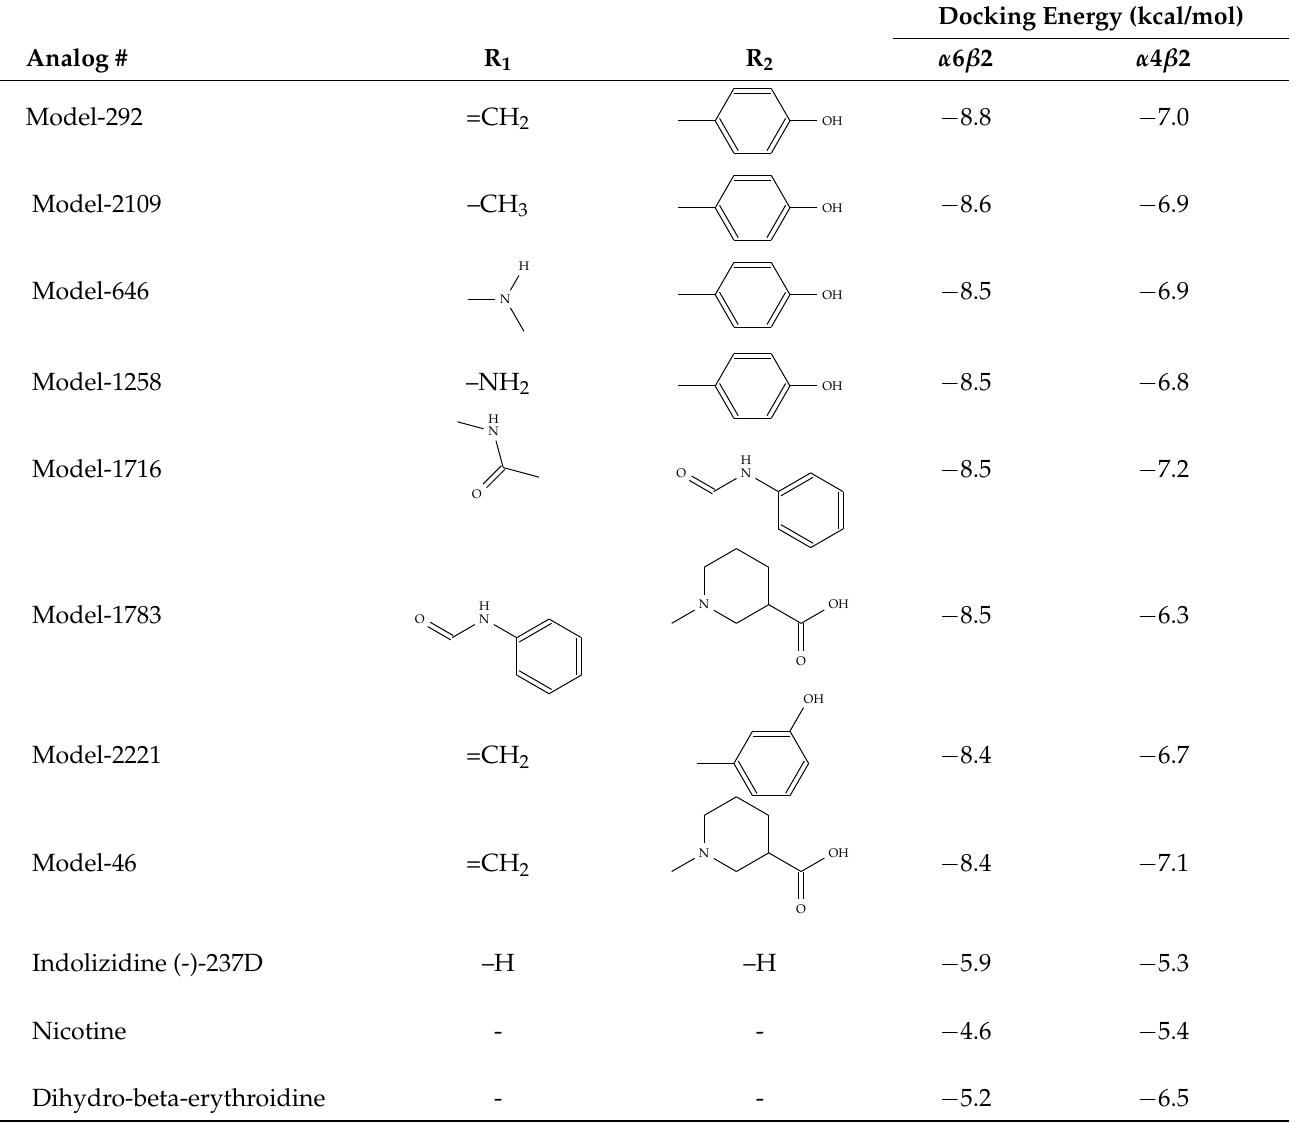
Table 2. Substitution patterns and docking energies of IND (-)-237D analogs with top docking